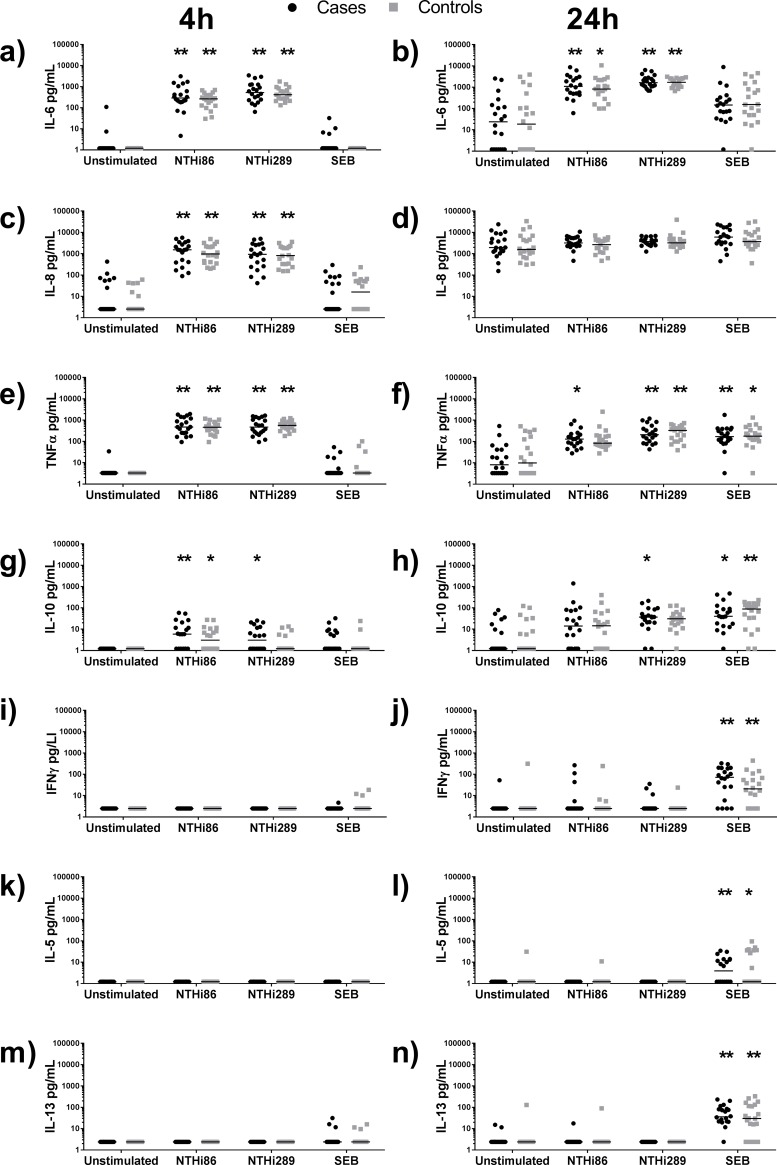
NTHi is a potent stimulator of innate inflammatory mediators regardless of susceptibility to OM.PBMC from otitis-prone children (cases; black dots) or non-otitis-prone children (controls; grey squares) were challenged with NTHi 86-028NP (NTHi-86), NTHi 289 or SEB and cytokine secretion was measured at 4h (left panel) or 24h (right panel) post-stimulation. Each dot represents a child and the horizontal lines represent the median level of cytokine production for each group. ** = p<0.001, * = p<0.05 when each stimulation was compared with unstimulated PBMCs from the same donors.